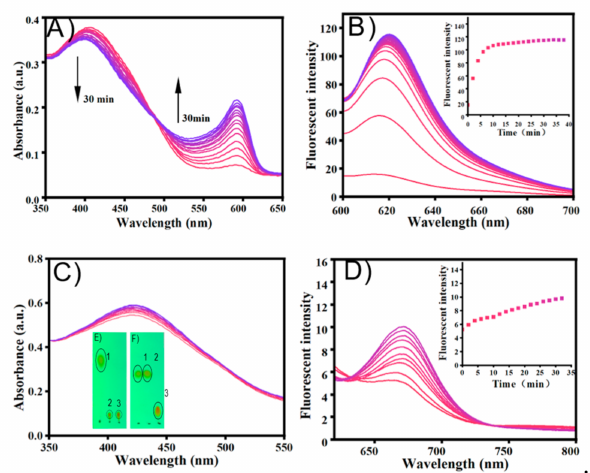
Figure 4. Absorption spectra of probe ( A ) TCF-ether (50 µ M) and ( C ) DCI-ether (50 µ M) in the presence of PdCl 2 (50 µ M) upon addition of CORM-2 (100 µ M) in PBS buffer (10 mM, pH 7.4, with 30% DMSO, v/v ) at 37 ◦ C for 30 min. Fluorescence spectra changes of probe ( B ) TCF-ether and ( D ) DCI-ether in the presence of PdCl 2 (50 µ M) upon addition of CORM-2 (100 µ M). Inset: Time- dependent fluorescence intensity of TCF-ether and DCI-ether. ( E ) Sample spotted in the TLC